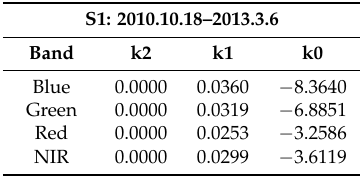
Table 4. The calibration coefficients of